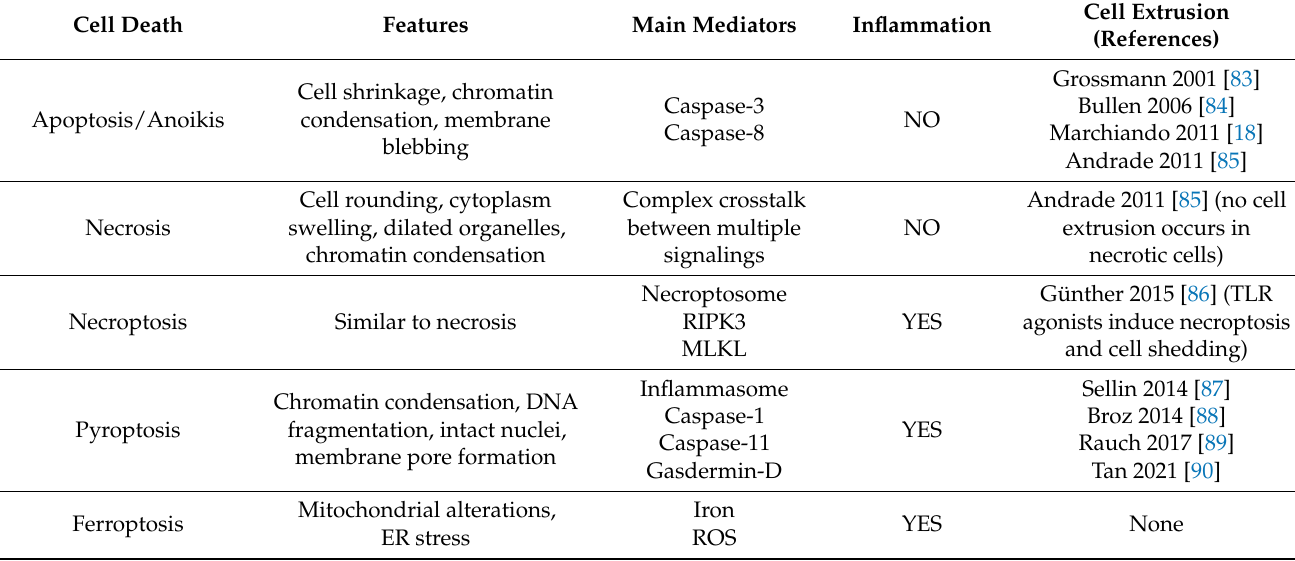
Table 1. Cell death pathways in the context of cell